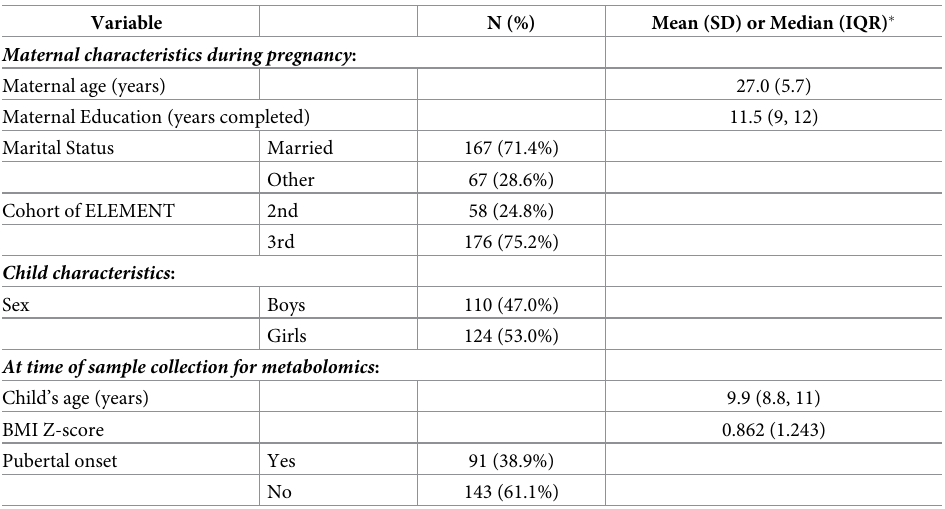
Table 1. Characteristics of the study population (n =